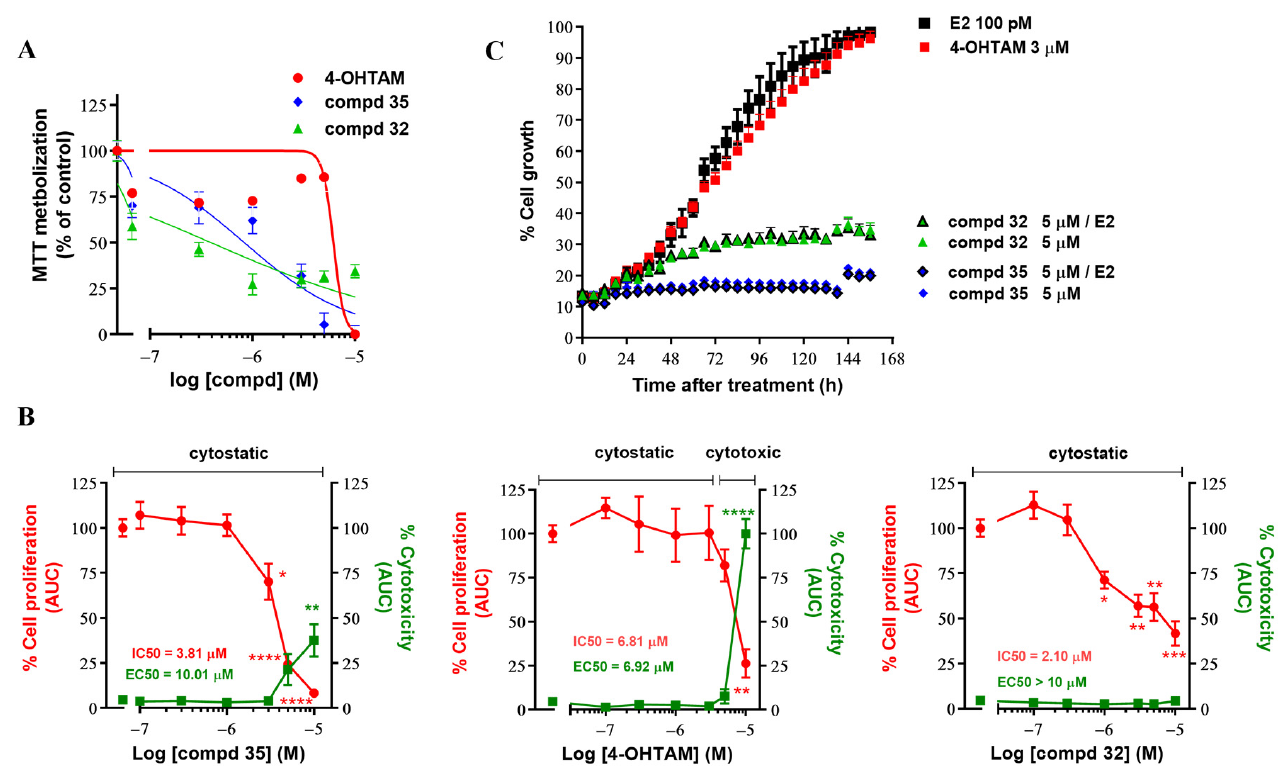
Figure 10. 5-Hydroxy-2 H -pyrrol-2-ones 32 and 35 inhibit ER+ endometrial cancer cell viability and proliferation in both serum-completed and E2-depleted media. Ishikawa cells were treated with vehicle (VEH, 0.05% DMSO), 4-hydroxy-tamoxifen (4-OHTAM; 0.01–10 µM) or compounds 32 or 35 (0.01–10 µM) in serum-completed media (10%FBS). ( A ) Cell viability was assessed after 72 h treatment by MTT assays as described in Materials and Methods. ( B ) Cell proliferation and cytotoxicity were assessed after 5 days monitorization. Data represent the area under the curve (AUC) by compounds dose in terms of proliferation in phase contrast (left Y -axis) and green-fluorescent cytotoxicity (right Y -axis). The mean ± SEM values are represented for each dose, comparing proliferation with respect to the maximum cell growth of VEH cells and the maximum cytotoxicity induced by 4-OHTAM at the highest dose. Data are expressed as mean ± SEM from at least triplicate independent experiments, where each compound concentration was assessed in triplicate. Statistical significance was assessed using one-way ANOVA with the Bonferroni post hoc test. * p < 0.05, ** p < 0.01, *** p < 0.001, **** p < 0.0001 vs. VEH-treated cells. ( C ) E2-depleted Ishikawa cells were treated with E2 (0.1 nM, (cid:4) ), compound 32 (5 µ M, (cid:78) ), compound 35 (5 µ M, (cid:117) ) or 4-OHTAM (3 µ M, (cid:4) ) (in the absence (VEH) or presence of E2 for 7 days. Cell growth kinetics were represented, and data were expressed as mean ± SEM for at least two independent experiments, where each treatment was tested in triplicate.